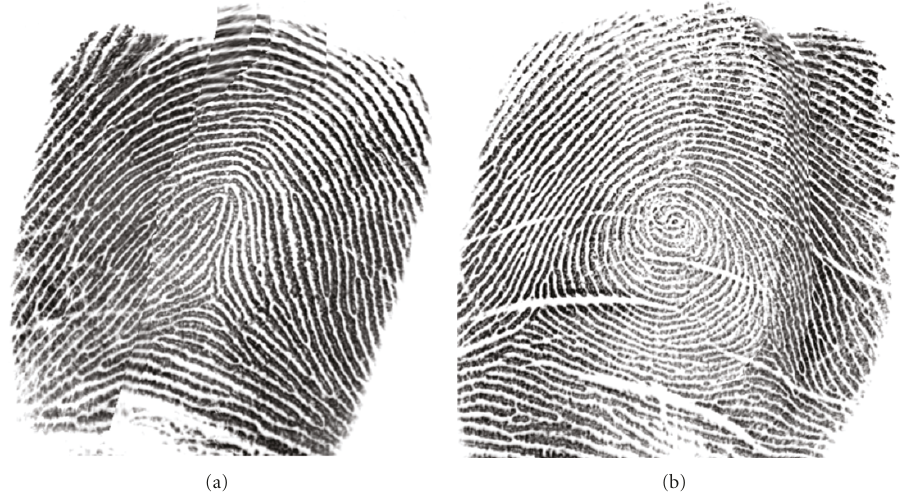
Figure 9: Smear images with abrupt